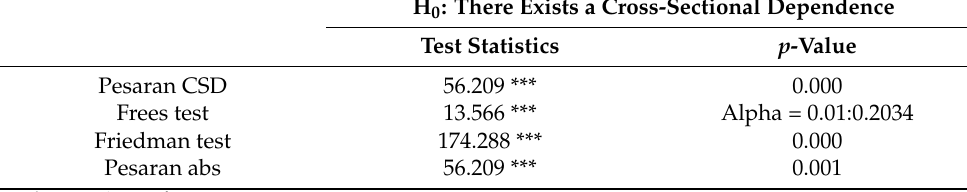
Table 3. Results of CSD test.